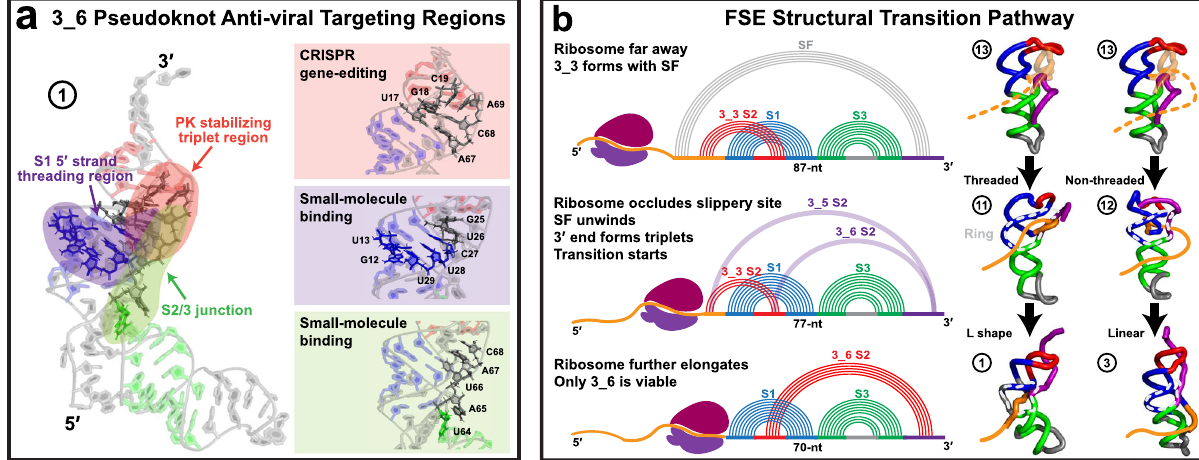
Fig. 8 Implications of the unraveled structures and motions to anti-viral therapeutics and frameshifting mechanisms. a Anti-viral target regions in the 3_6 pseudoknot. b Proposed structural transition pathway for the SARS-CoV-2 frameshifting element. The loop region of Stem 1 is colored red, the 5 0 end orange, and the 3 0 end purple. The 87-nt 3_3 model shown at top has the two ends base paired to form stem SF, and a potential threaded and non-threaded 5 0 end is plotted as dashes. The 77-nt 3_3 models in the middle have triplets that contain alternative Stem 2 interactions, and the ring starts to close (circled in gray), with the 5 0 end threading through or winding around. The 77-nt 3_6 models at bottom has a threaded L shape and a non-threaded linear shape. The 5 0 ends in these models are extended just for illustration. The trajectory numbers of the representative conformations are indicated as de fi ned in Table 1. The 3D models are drawn with PyMol using the cartoon rendering option 77 .